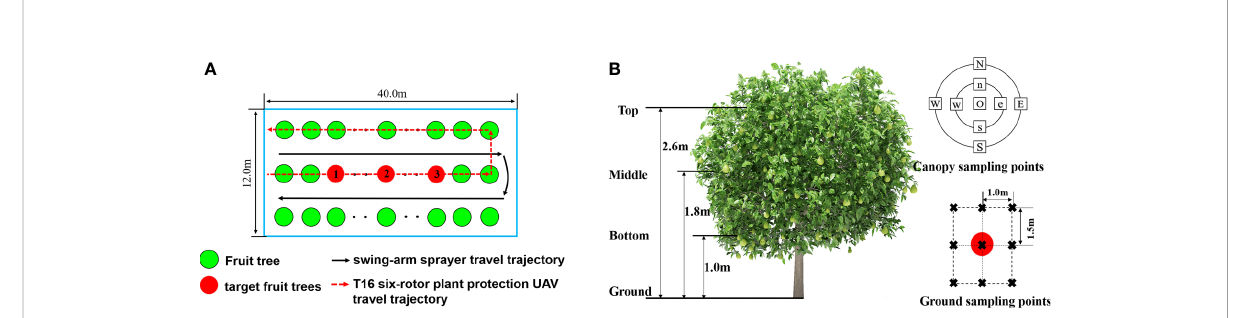
FIGURE 8 Sampling scheme. (A) Selection of target fruit trees. (B) Sampling point layout